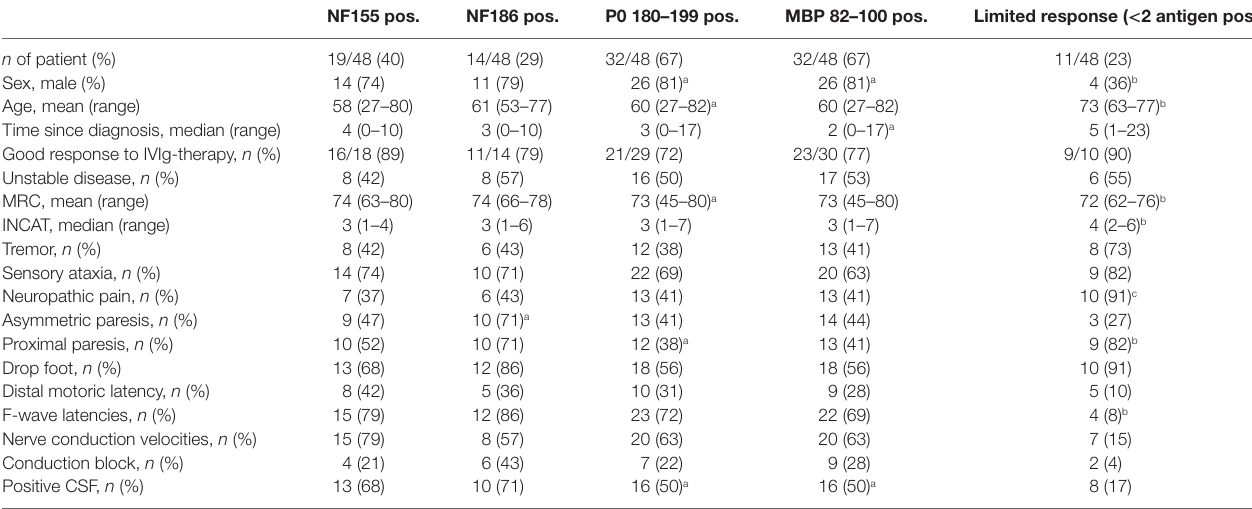
TaBle 2 | Clinical characteristics of ELISPOT antigen-responsive patients and patients with limited antigen-specific response. nF155 pos. nF186 pos. P0 180–199 pos. MBP 82–100 pos. limited response ( < 2 antigen